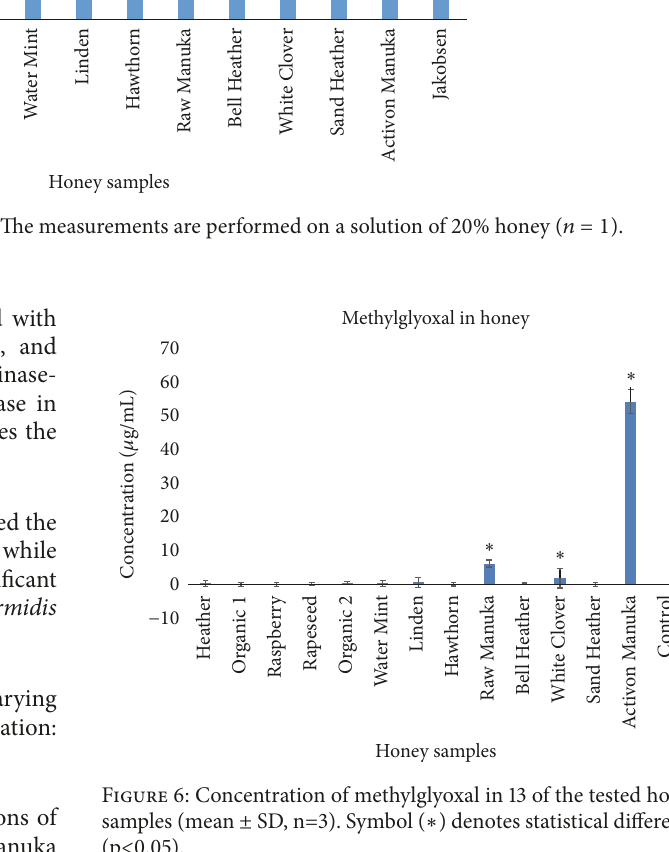
Figure 6: Concentration of methylglyoxal in 13 of the tested honey samples (mean ± SD, n=3). Symbol ( ∗ ) denotes statistical difference (p <